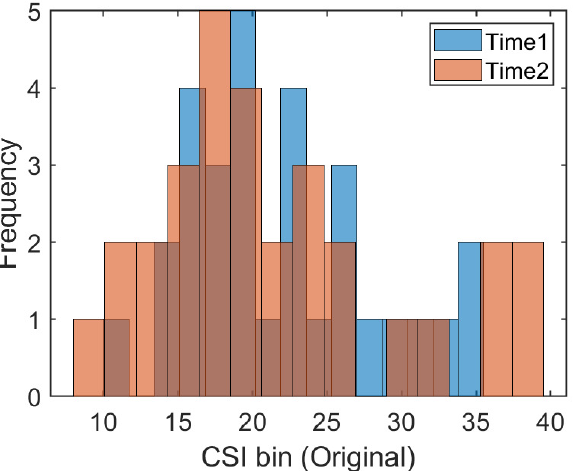
Figure 1. The frequency histograms at position #1 during the two time periods.